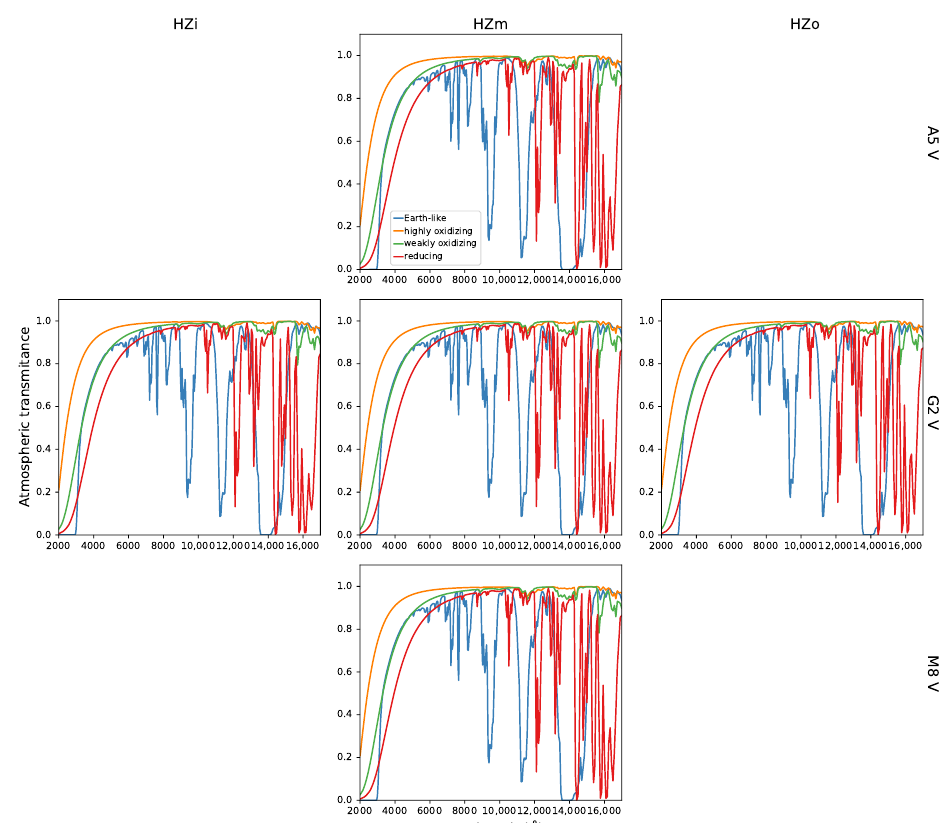
Figure A3. Atmospheric transmittance of exoplanets for different stellar spectral types and planet separations. Middle column: Transmittance in the middle of the exoplanet habitable zone (HZm) for A5V, G2V, and M8V stars. Left and right columns : Inner and outer habitable zones (HZi and HZo, respectively) for a G2V